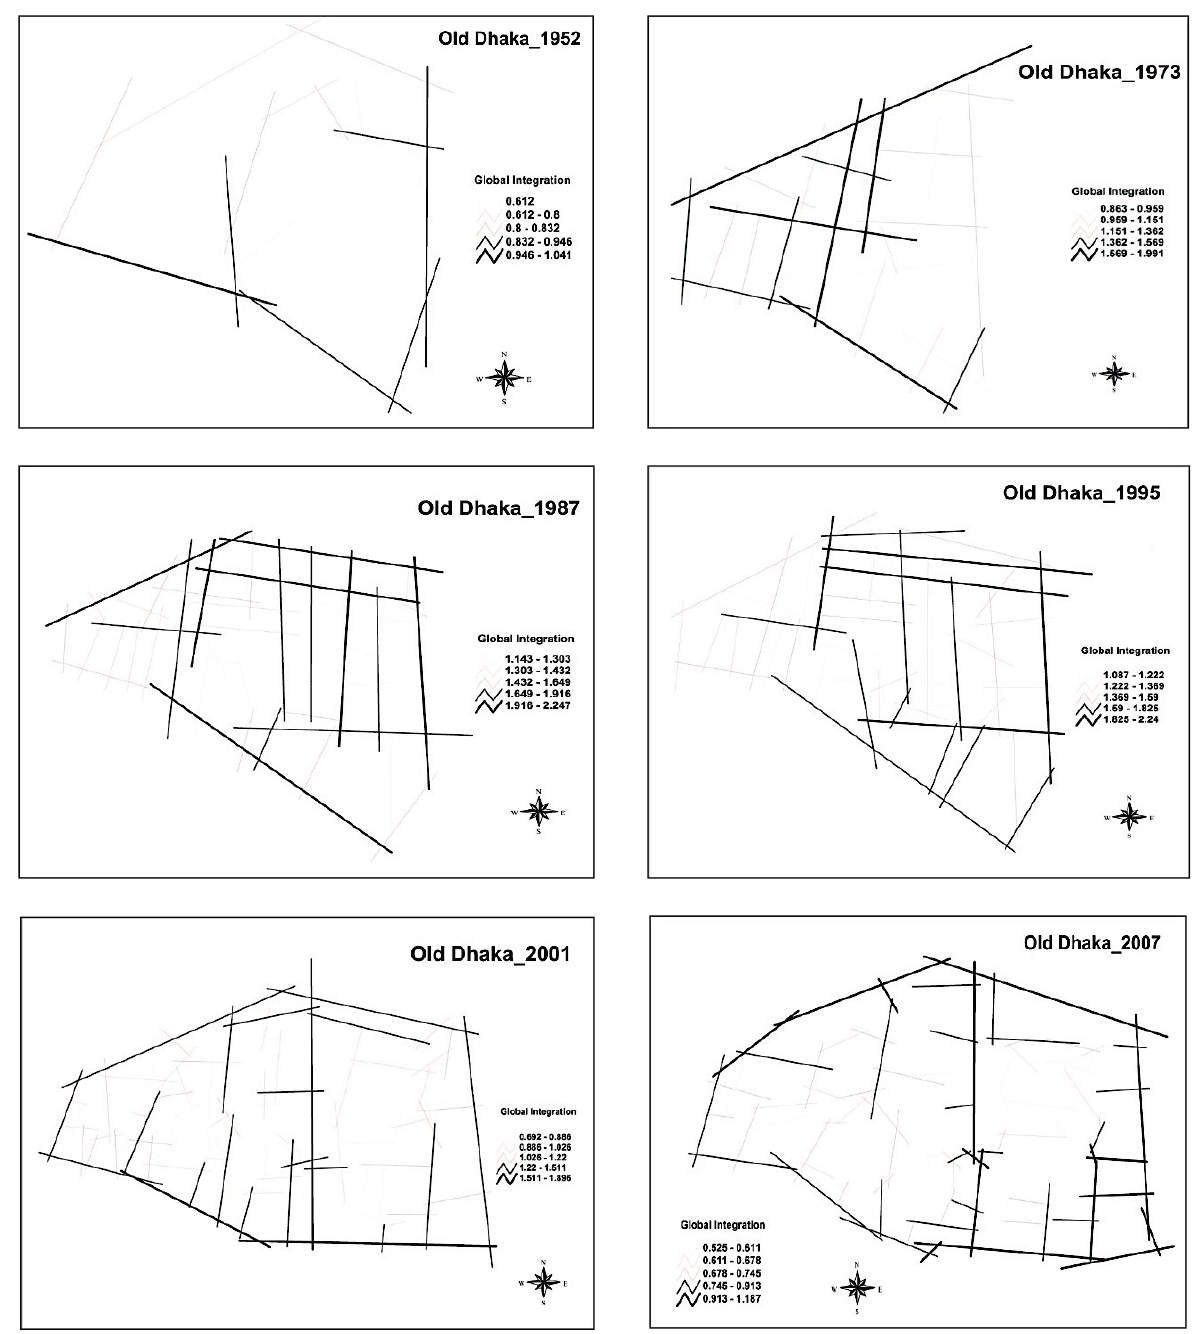
Figure 6. Global integration (R = n ) maps of (Old Dhaka) ward 72 (not to